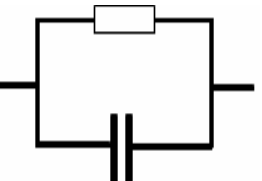
Figure 3. Schematic illustration of the electrical equivalent circuit (EEC). Resistor is represented by the symbol and capacitor represented by .